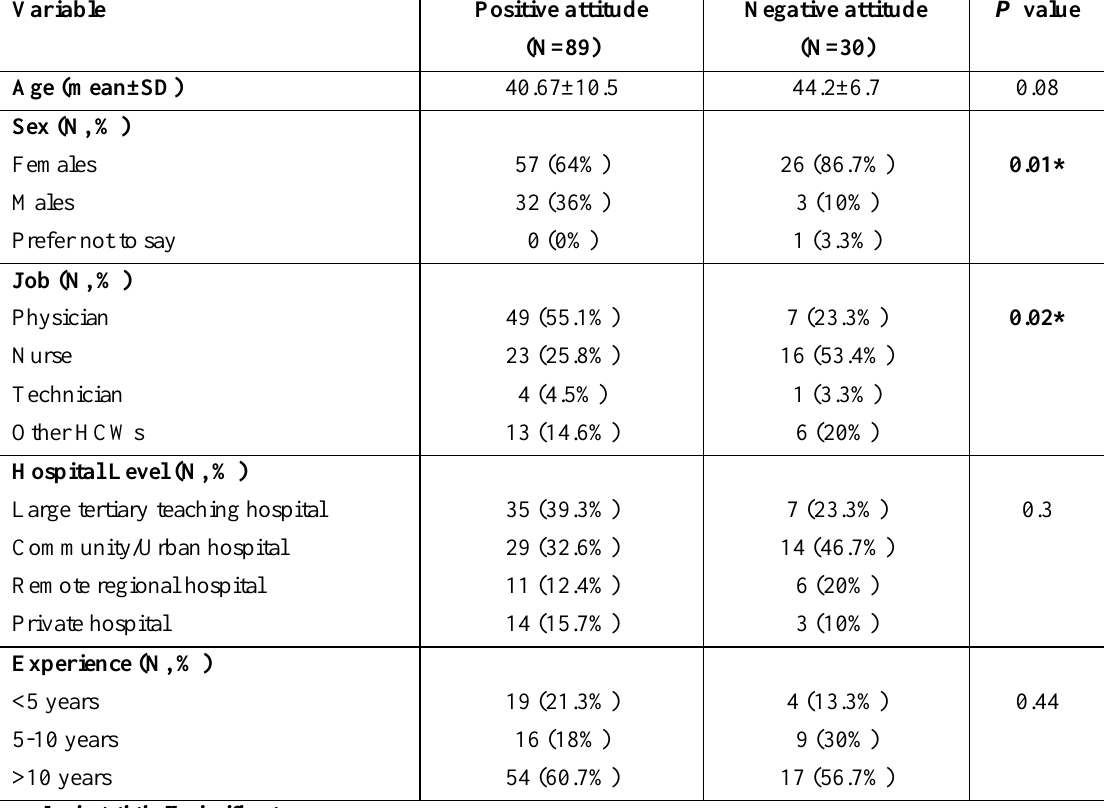
Table 5. Demographic factors related to positive attitude towards PPE among the participants.